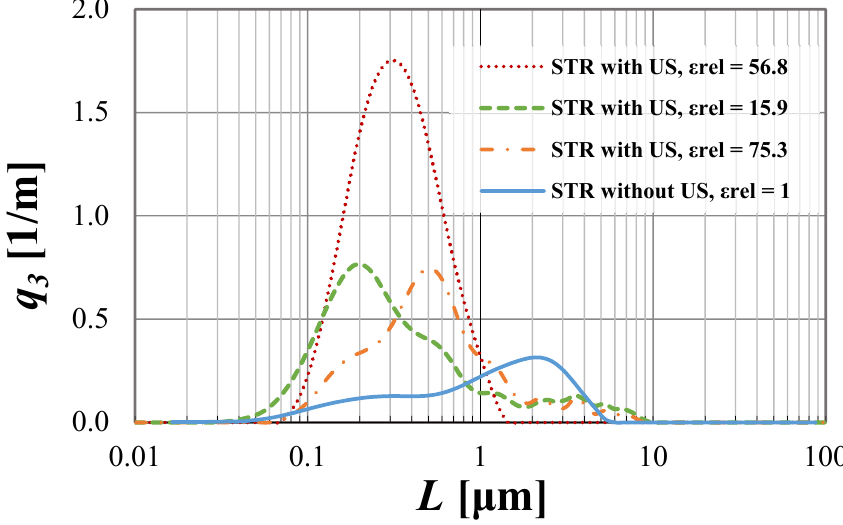
Figure 5. Particle density distributions of crystals obtained for different values of ε rel by the use of